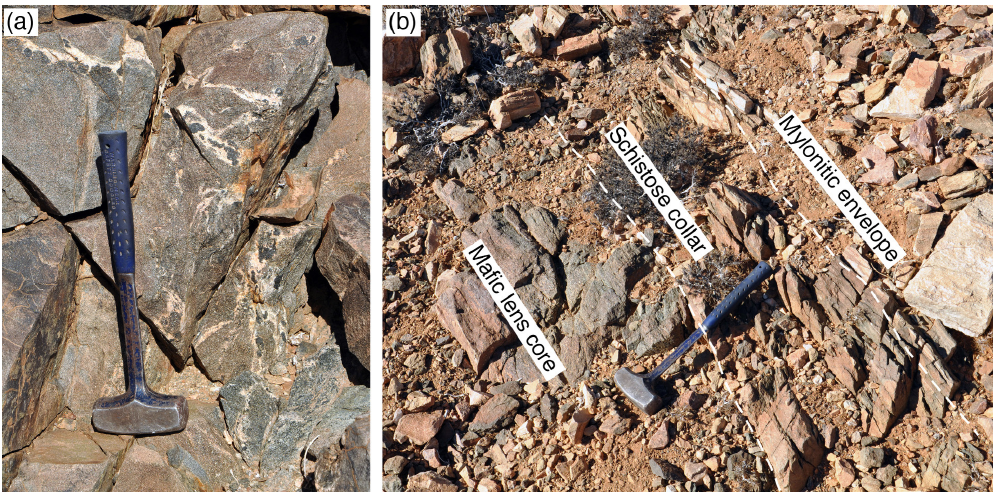
Figure 2. Field photographs of mafic lenses within the KMZ. (a) Detail of the unsheared core of a lens, showing coarse-grained amphibolite with evidence of small-scale migmatization in the form of leucosome stringers and ponds. (b) Boundary of mafic lens showing the increase in strain over a distance of 35cm. Hammer is 40cm